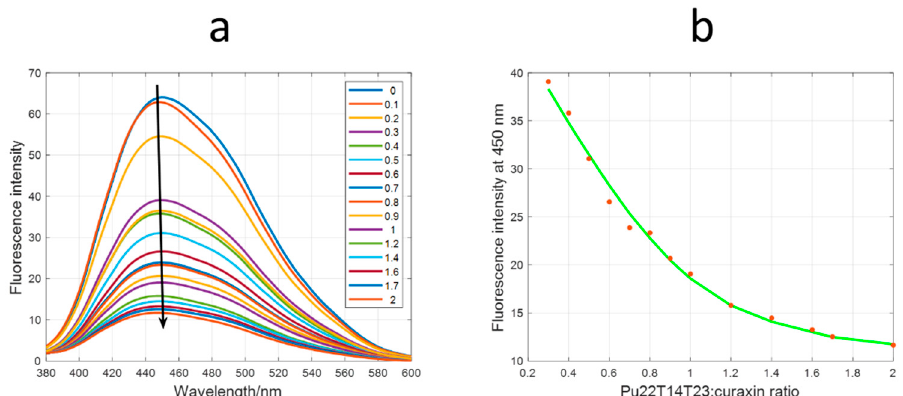
Figure 8. Molecular fluorescence-monitored titration of curaxin with Pu22T14T23. ( a ) Experimental spectra measured along the titration. Numbers in inset indicate the DNA:curaxin ratio; ( b ) experi- mental (symbols) and fitted (line) fluorescence at 450 nm. A 1:1 (DNA:curaxin) stoichiometry was used to model the data.